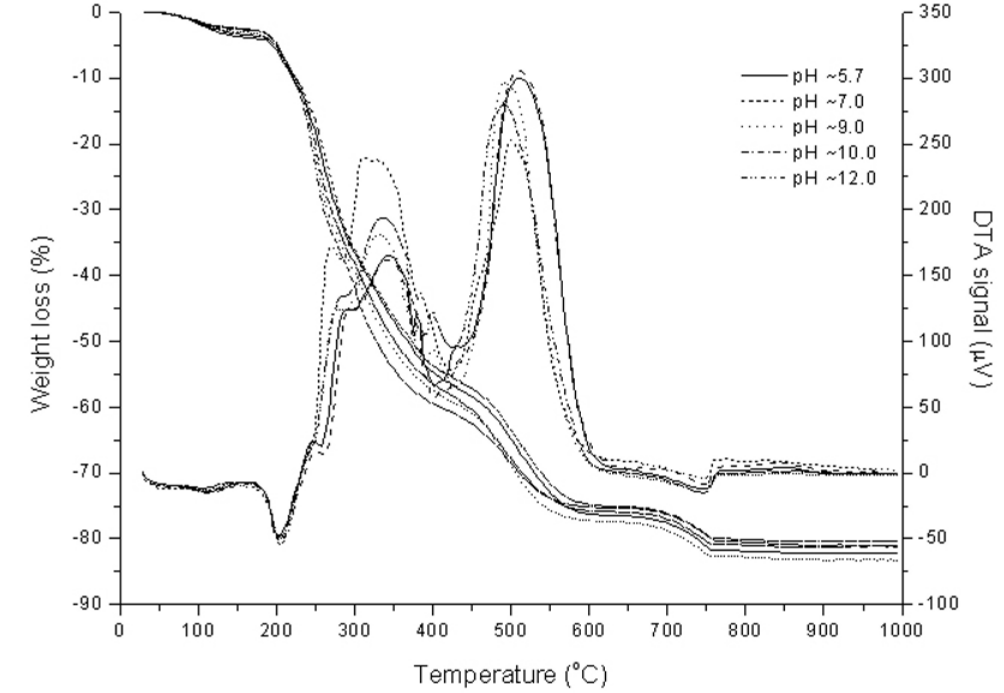
Figure 2. TG curves and DTA profiles for the Ca-P-O precursor gels at different pH values in the sol-gel